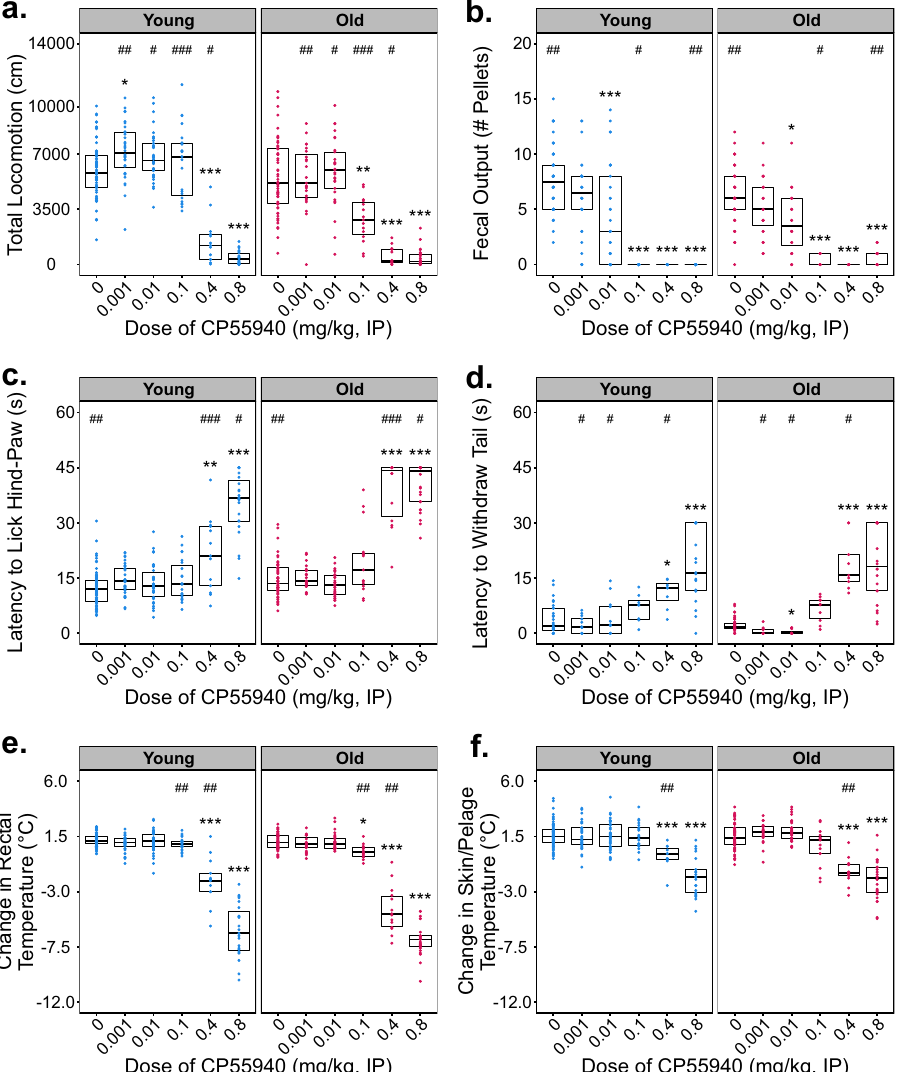
Fig. 1 Effects of CP55940 on locomotion, thermoregulation, and nociception in Young – adult (4 m) and old (22 m) C57BL/6 mice. CP55940 was administered via intraperitoneal injection at doses ranging from 0.001 to 0.8 mg/kg to young and old male and female mice. Individual data points for each testing group are overlaid on Tukey-style boxplots. The lower and upper edges of each box represent the fi rst and third quartiles, respectively. The middle horizontal line in each box depicts the median of that dose/age group. Sample sizes for every treatment group and fi gure panel are listed in Supplementary Fig. 5. Statistical comparisons of age, dose, and age:dose interactions were made using the nonparametric Scheirer – Ray – Hare test. Signi fi cant omnibus results were followed by planned post hoc contrasts of each dose vs. vehicle- treated control groups using Dunn ’ s method. The false discovery rate was corrected for using the Benjamini, Hochberg, and Yekutieli method. Within an age group, signi fi cant differences ( P < 0.05) between a given dose and the vehicle response (0 dose) are indicated using asterisks (*). Differences between age groups at a given dose are indicated by pound signs (#). a , b Total locomotion and fecal output during open- fi eld testing, 30 – 60 min after injection of CP55940 or vehicle. c Latency to exhibit nociceptive behavior when place on a 52 °C hot plate. d Latency to withdraw the tail from 46 °C water. e Change in rectal temperature 60 m after injection of drug. f Change in infrared recording of skin/ pelage temperature 60 m after injection of